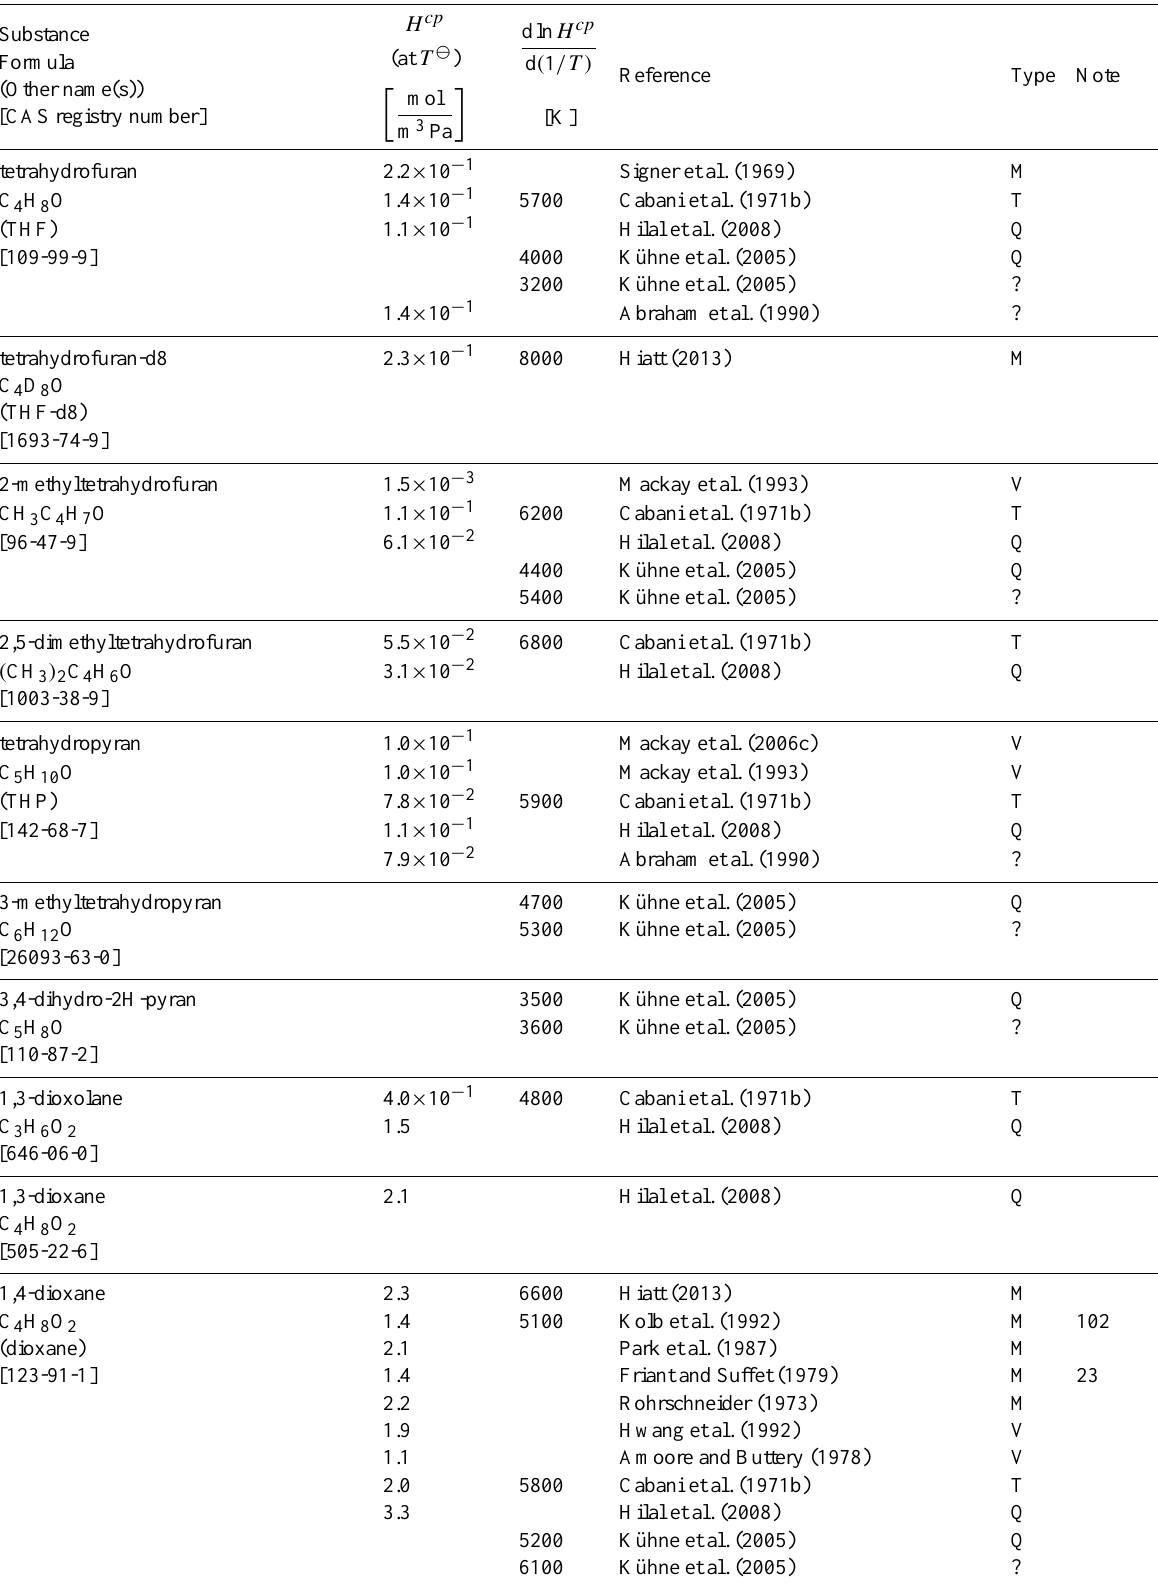
Table 6: Henry’s law constants for water as solvent